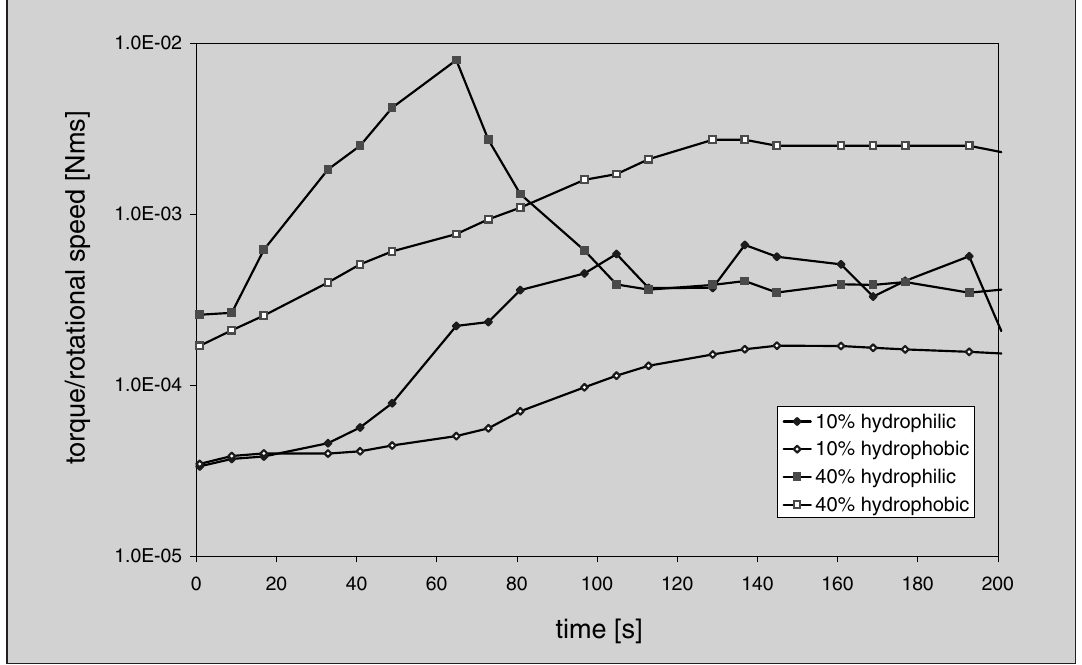
Figure 4: Viscosity progression for mixtures of hydrophilic and hydrophobic glass sphere suspensions with a w/o emulsion at 0.48